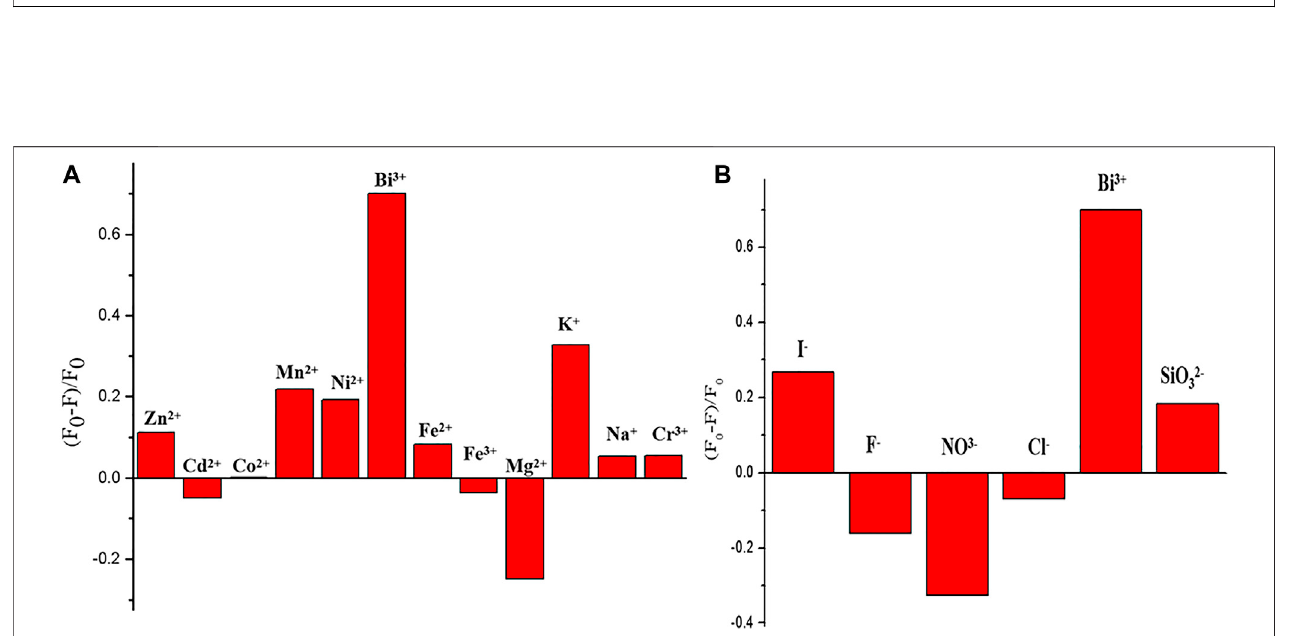
FIGURE 4 | Fluorescence intensity of GSH-CuNPs at 475 nm under the existence of various cations (A) and anions (B) .